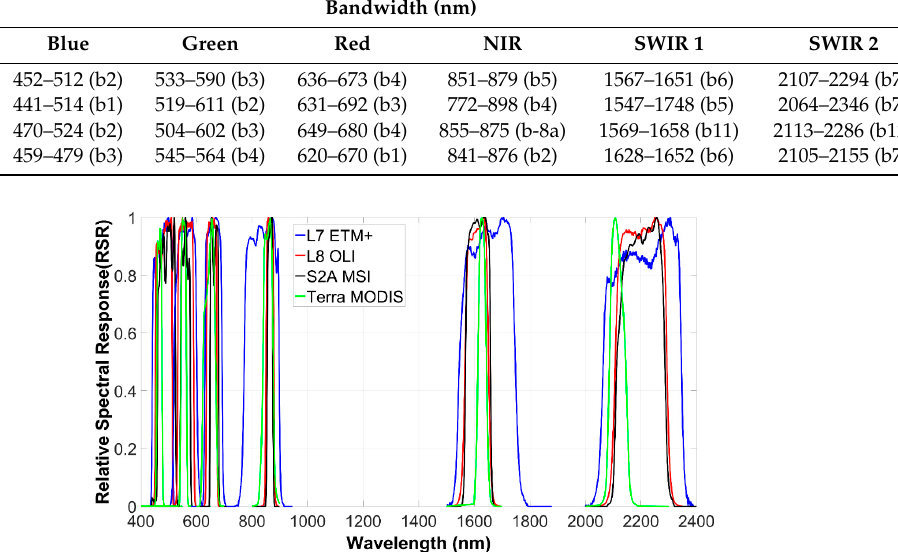
Figure 1. Relative Spectral Response of four Sensors for six analogous spectral bands.